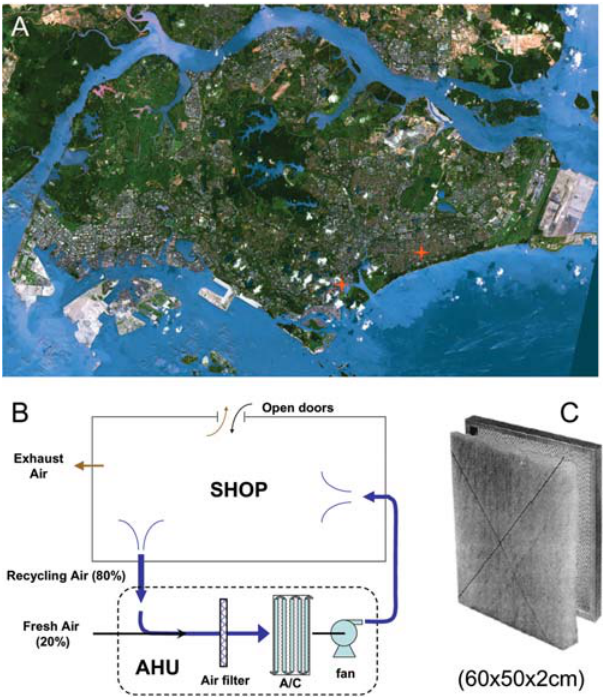
Figure 1. Air sampling location and device. A. The Singapore map and the two sampling locations (indicated by red stars) in Singapore. B. A schematic view of the air handling unit (AHU) filtration system used in the two buildings. C. An air panel filter (60 6 50 6 2 cm 3 ) used in this study.